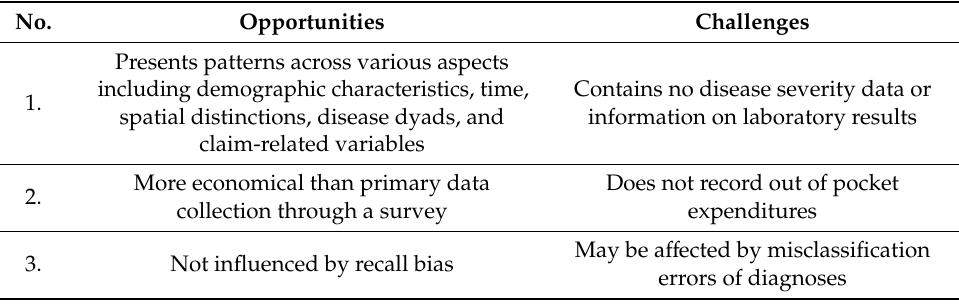
Table 3. Opportunities and challenges of utilizing Indonesian National Health Insurance sample data as a complementary data source for chronic disease